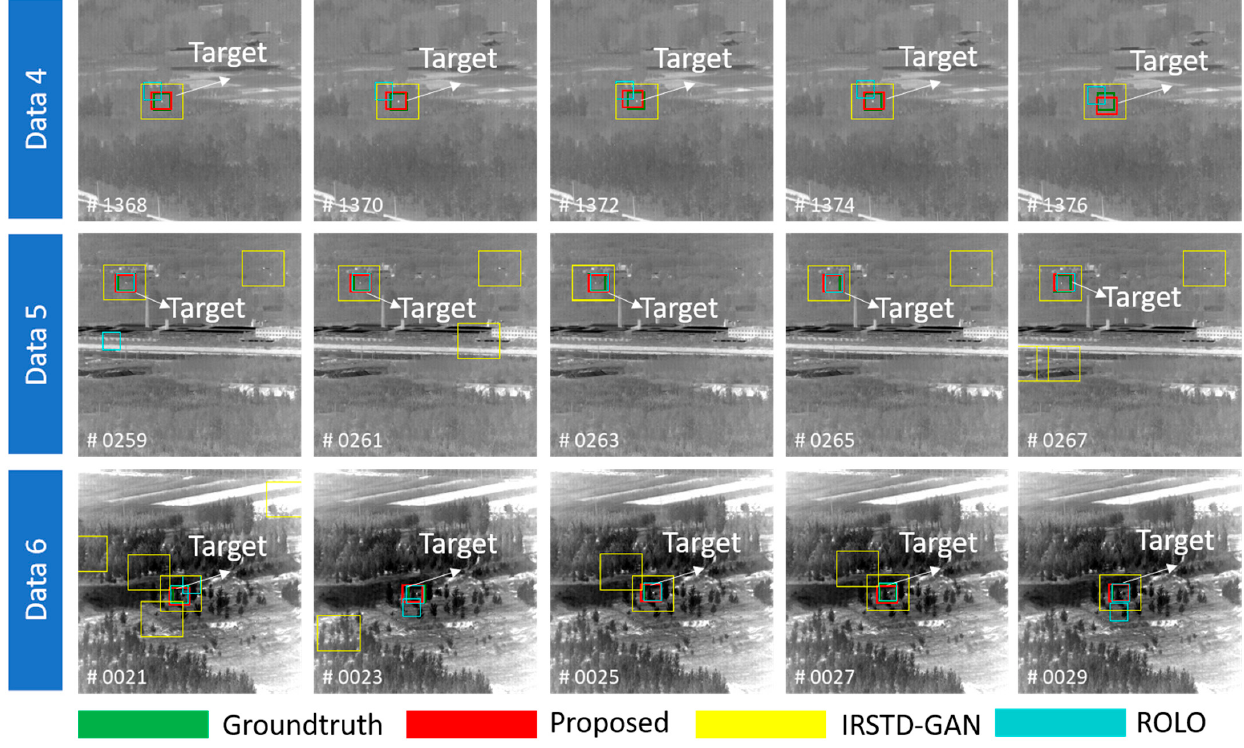
Figure 18. Detection results between our method and CNN-based methods in public datasets. The target has been marked by texts, and the other prediction boxes are false alarms. Experimental results show that the proposed method has the highest coincidence with the ground truth.